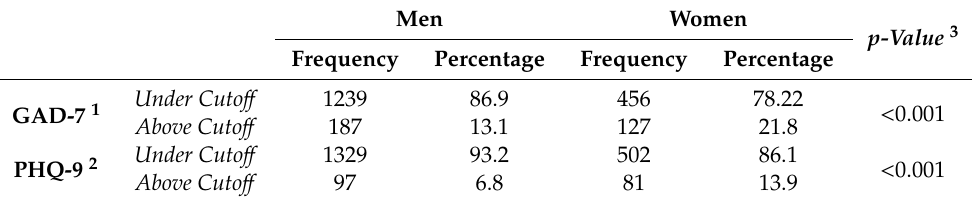
Table 3. Sex and psychological characteristics of the